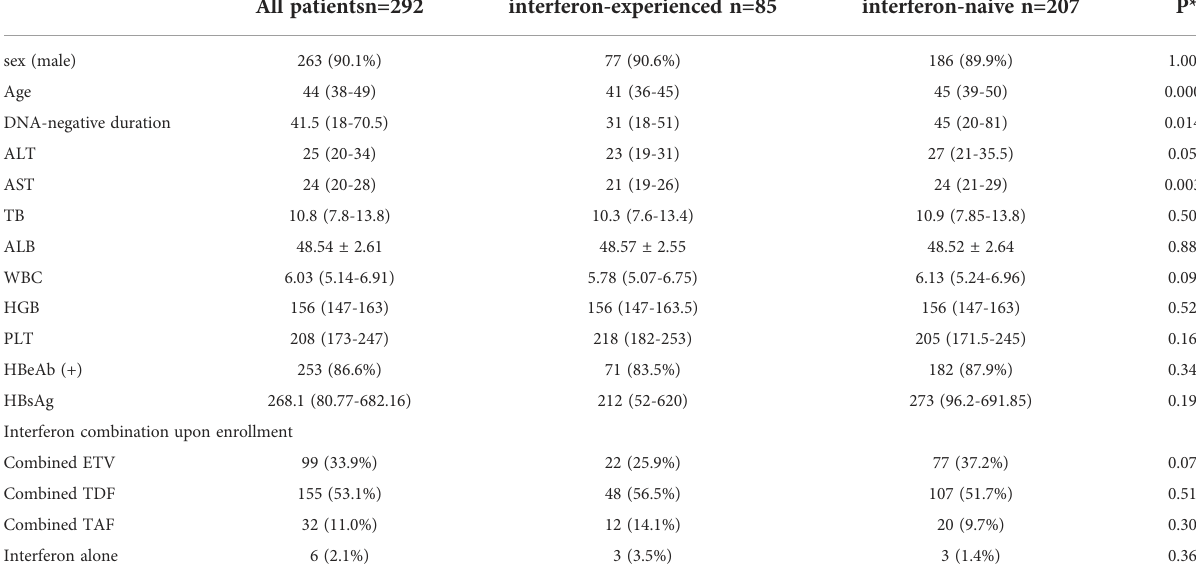
TABLE 1 Baseline